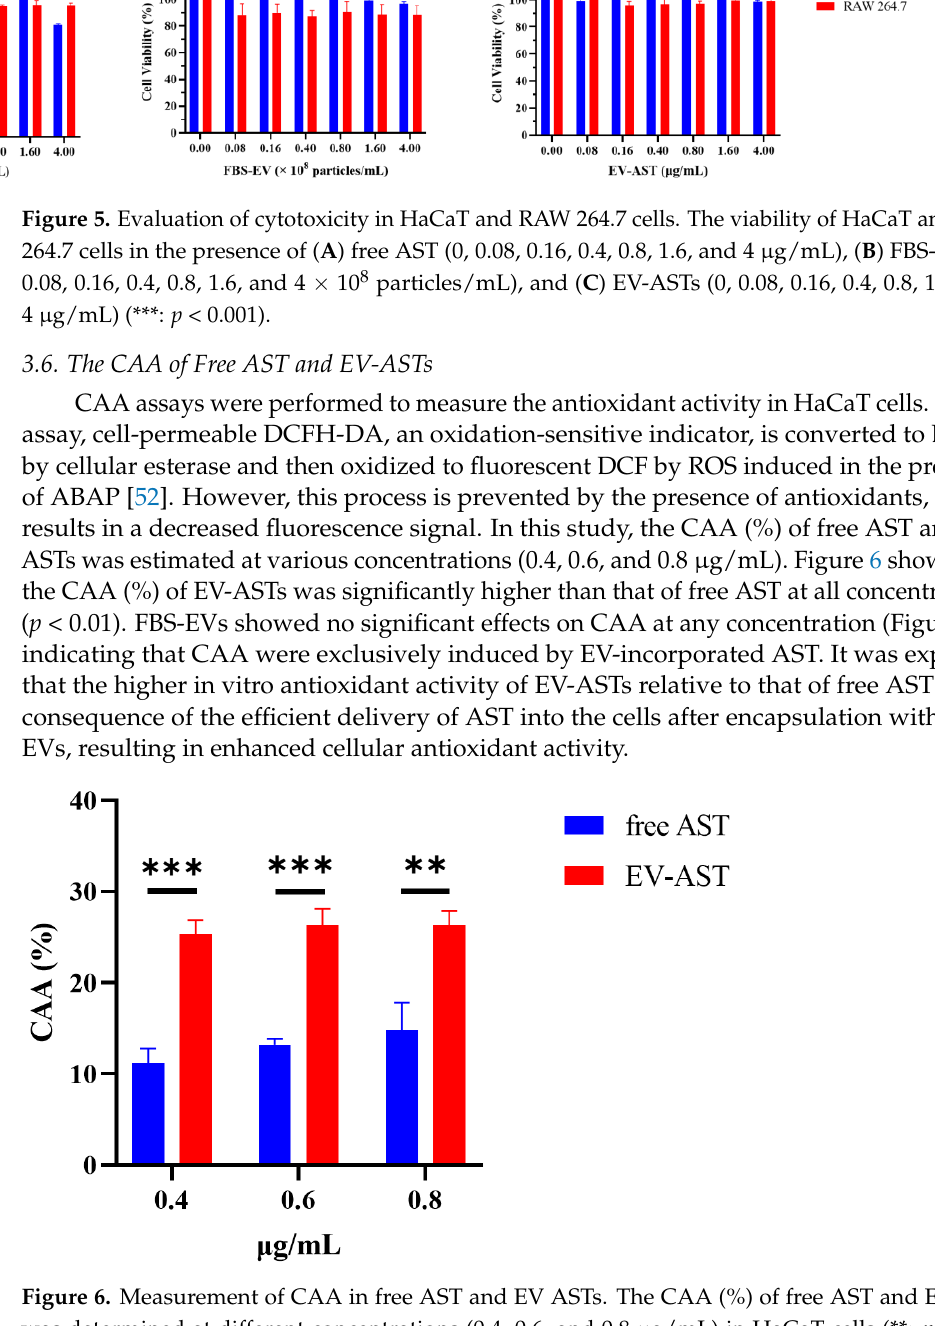
10 of 16 Figure 4. ABTS radical scavenging activity (%) of free AST and EV-AST at concentrations of 0, 0.5, 1.5, 2.5, 3.5, 4.5, and 5 μg /mL (**: p < 0.01; ***: p < 0.001). 3.5. Evaluation of Cytotoxicity in HaCaT and RAW 264.7 Cells The cytotoxicity of free AST, FBS-EVs, and EV-ASTs on HaCaT and RAW 264.7 cells was measured via the CCK-8 assay. Figure 5A shows that RAW 264.7 cell viability was unaffected by free AST, whereas that of HaCaT cells was adversely affected by concentra-